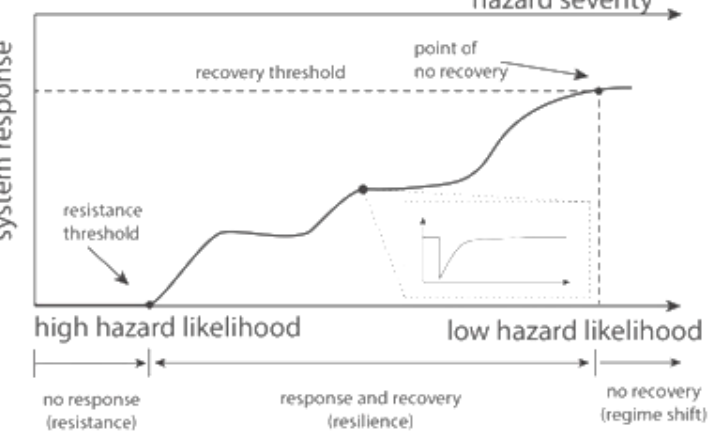
Fig. 2. System response as a function of disturbance magnitude [1].